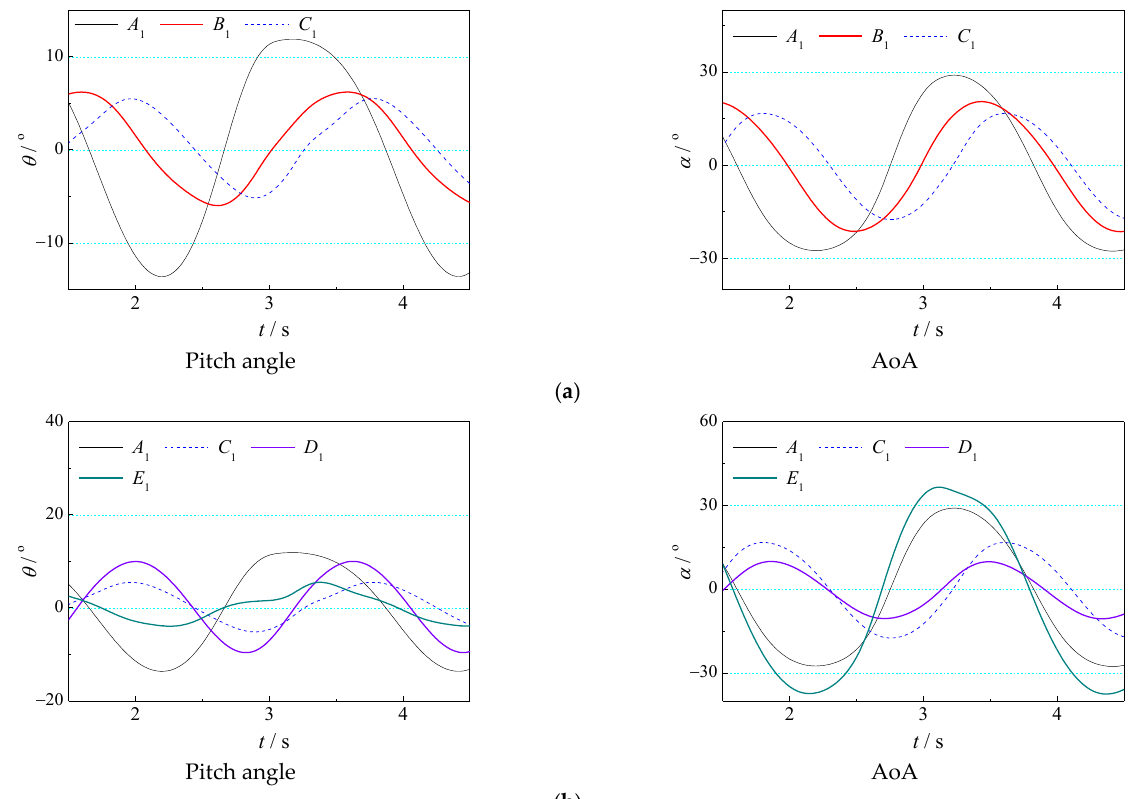
Figure 19. The time–history of pitch angle θ and AoA α under five working conditions in Figure 18. ( a ) Time traces of the pitch angle and AoA of three working points A 1 , B 1 , and C 1 . ( b ) Time traces of the pitch angle and AoA of four working points A 1 , E 1 , C 1 , and D 1 .